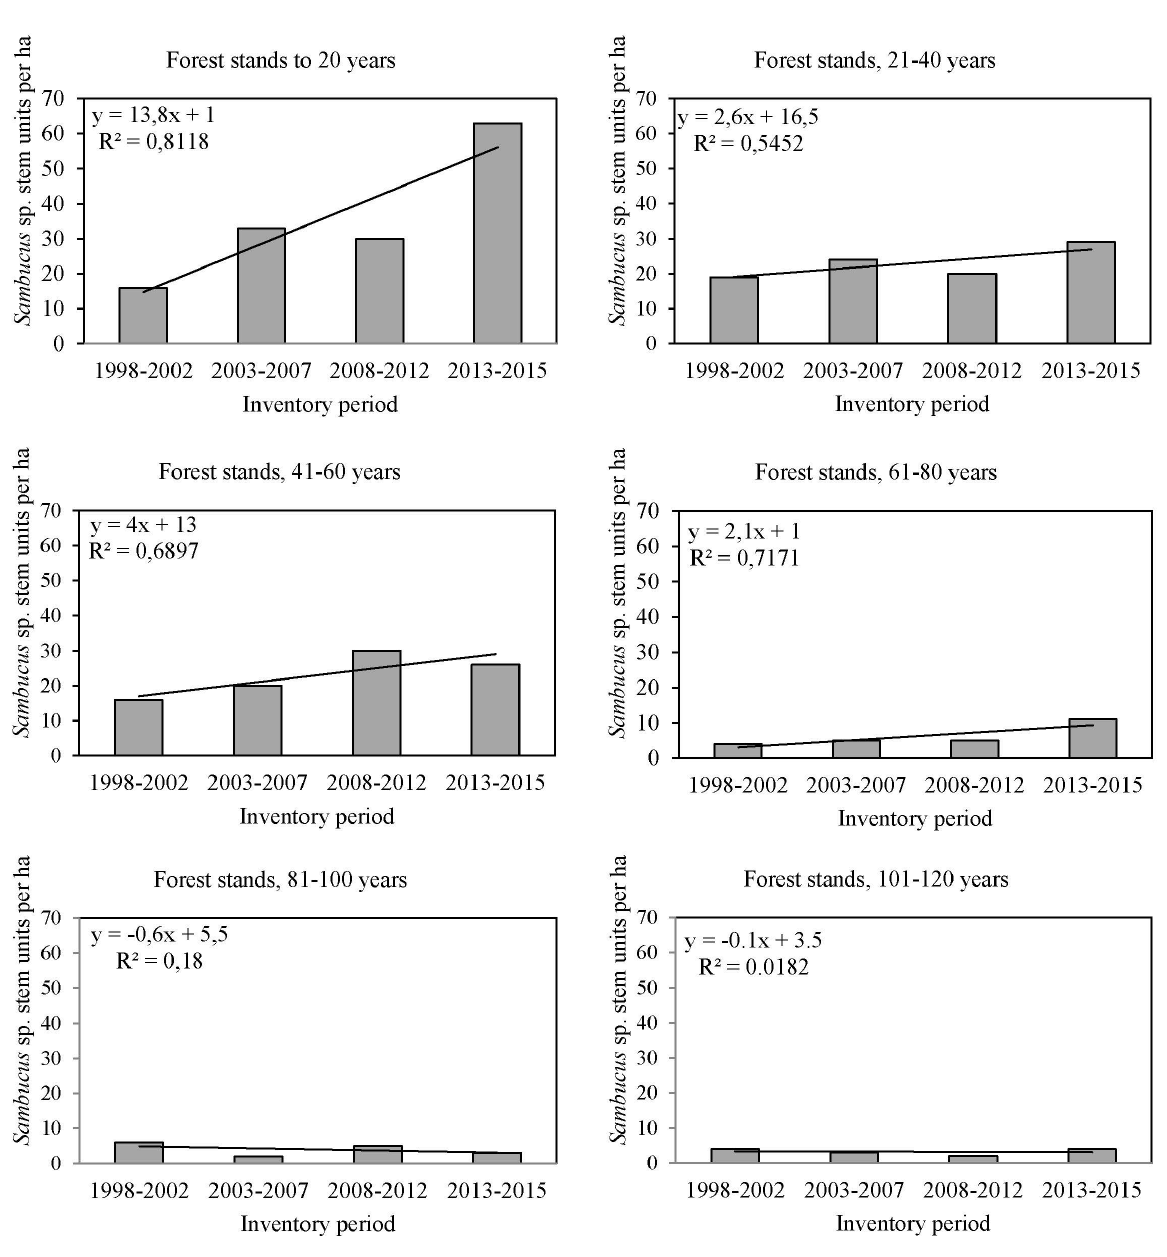
Figure 7. Dynamics of Sambucus sp. abundance in 1998-2015 years according the age of different stands and number of individuals per